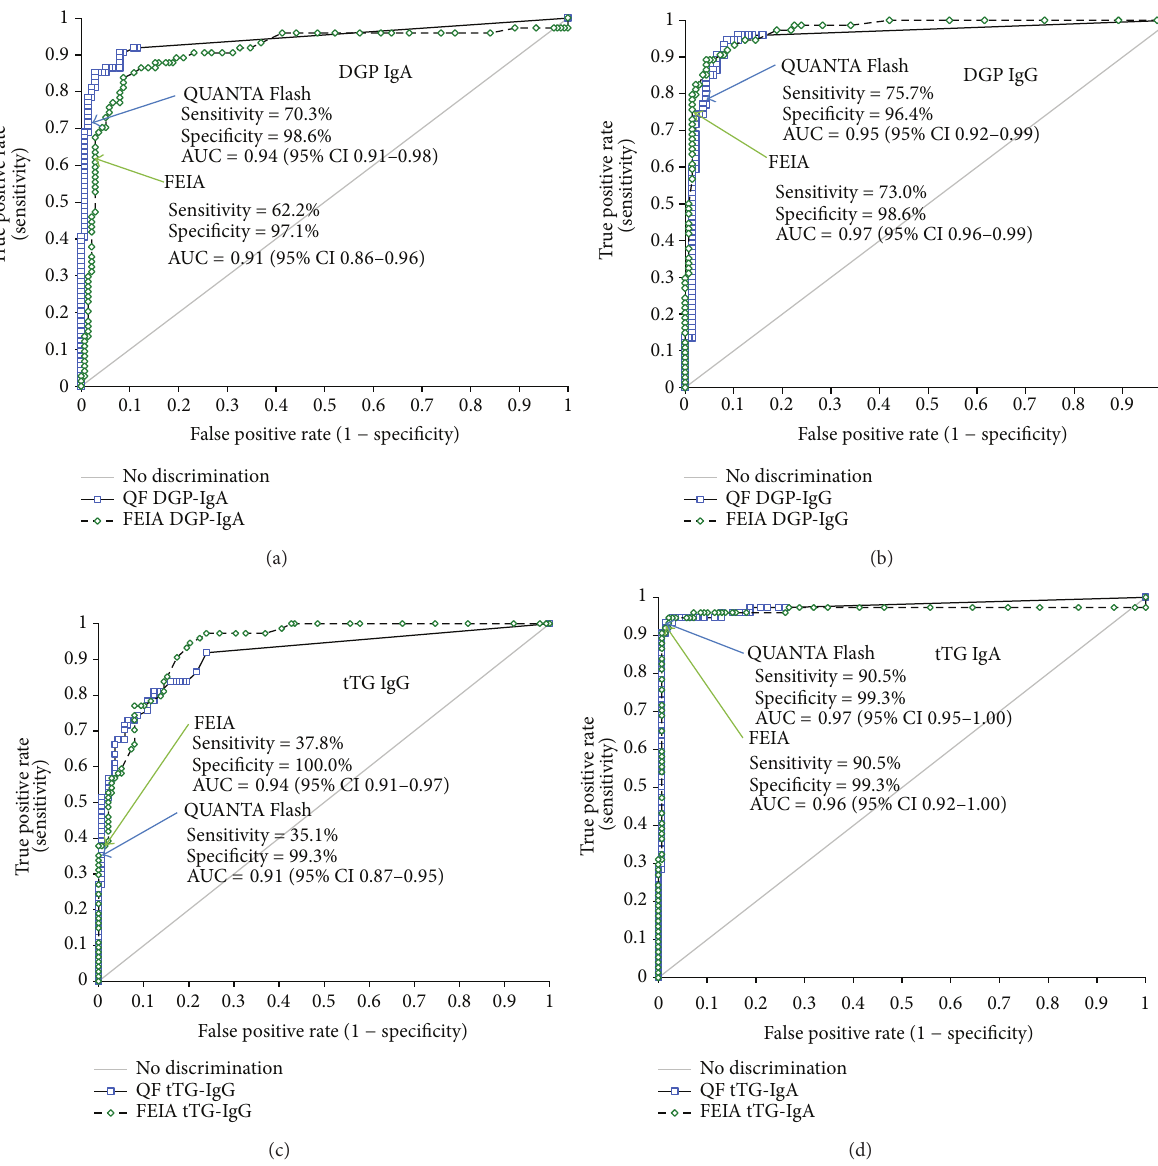
Figure 1: Comparative ROC curve analyses. ROC for QUANTA Flash DGP IgA and FEIA DGP IgA is shown in (a), for QUANTA Flash (QF) DGP IgG and FEIA DGP IgG in (b), for QUANTA Flash h-tTG IgG and FEIA IgG in (c), and for QUANTA Flash h-tTG IgA and FEIA IgA in (d). The ROC curves were similar for tTG IgA, tTG IgG, and DGP IgG. For DGP IgA, the AUC (especially in the clinically relevant area) was higher for QF versus FEIA. Note: clinical sensitivity and specificity as well as arrows pointing to cutoffs in this figure are for equivocal samples considered as positive for FEIA